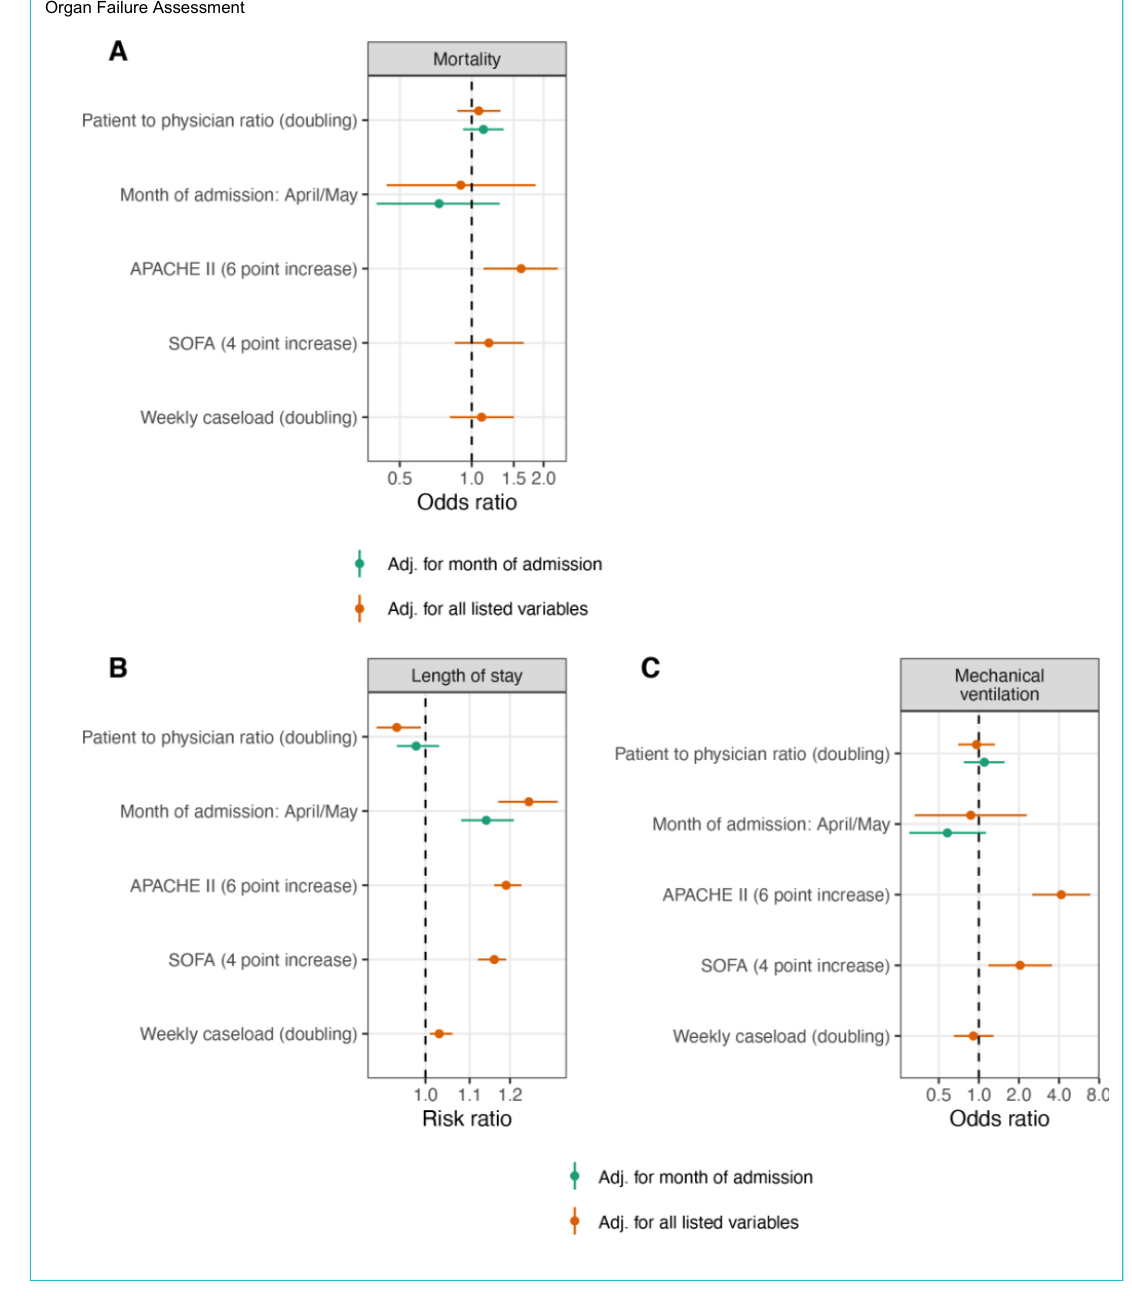
Figure 5: Patient-to-physician ratio and study outcomes. APACHE II = Acute Physiology and Chronic Health Evaluation II, SOFA = Sequential Organ Failure